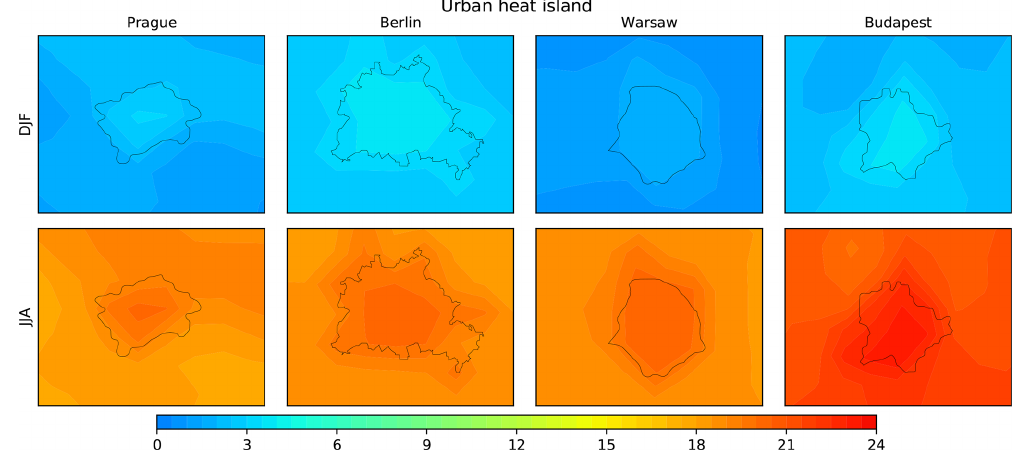
Figure 7. Multi-model-averaged winter and summer 2m air temperatures ( ◦ C) around Prague, Berlin, Warsaw and Budapest.